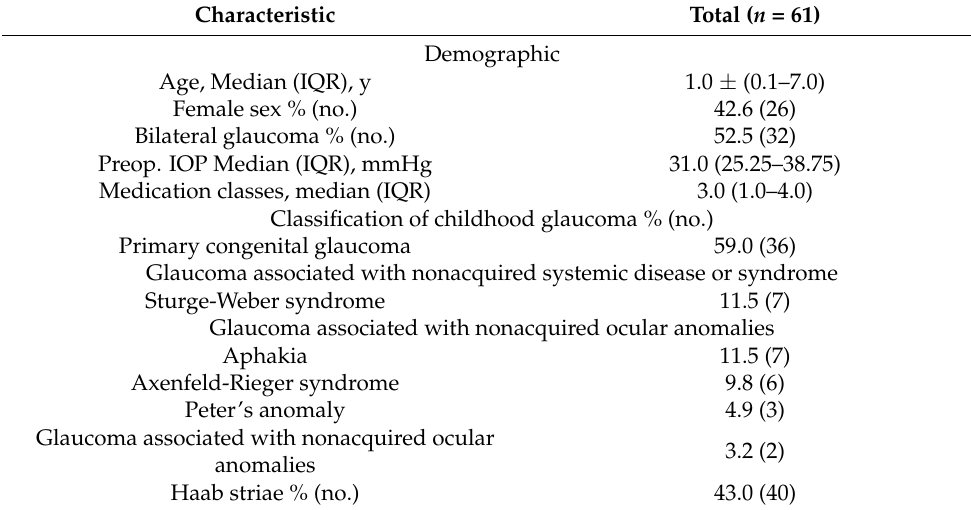
Table 1. Baseline characteristics.